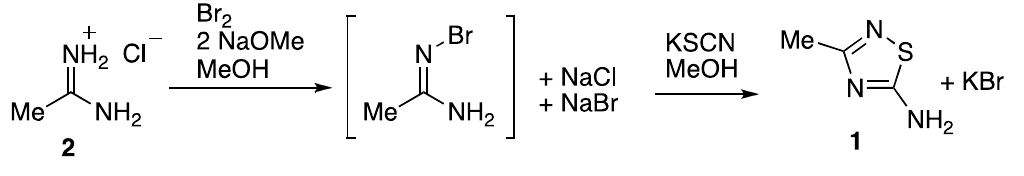
Scheme 1. Synthetic route to 1 [1].